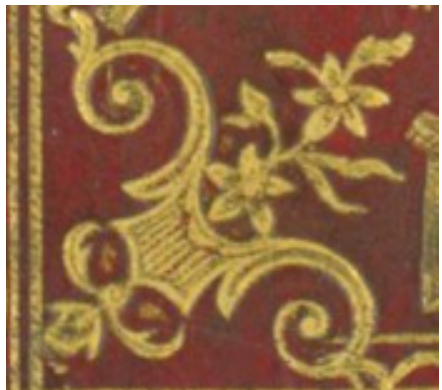
Fig. 32. The Constitutions of the ... Masons (London, 1767-1776). Enlargement of corner tool. BL,